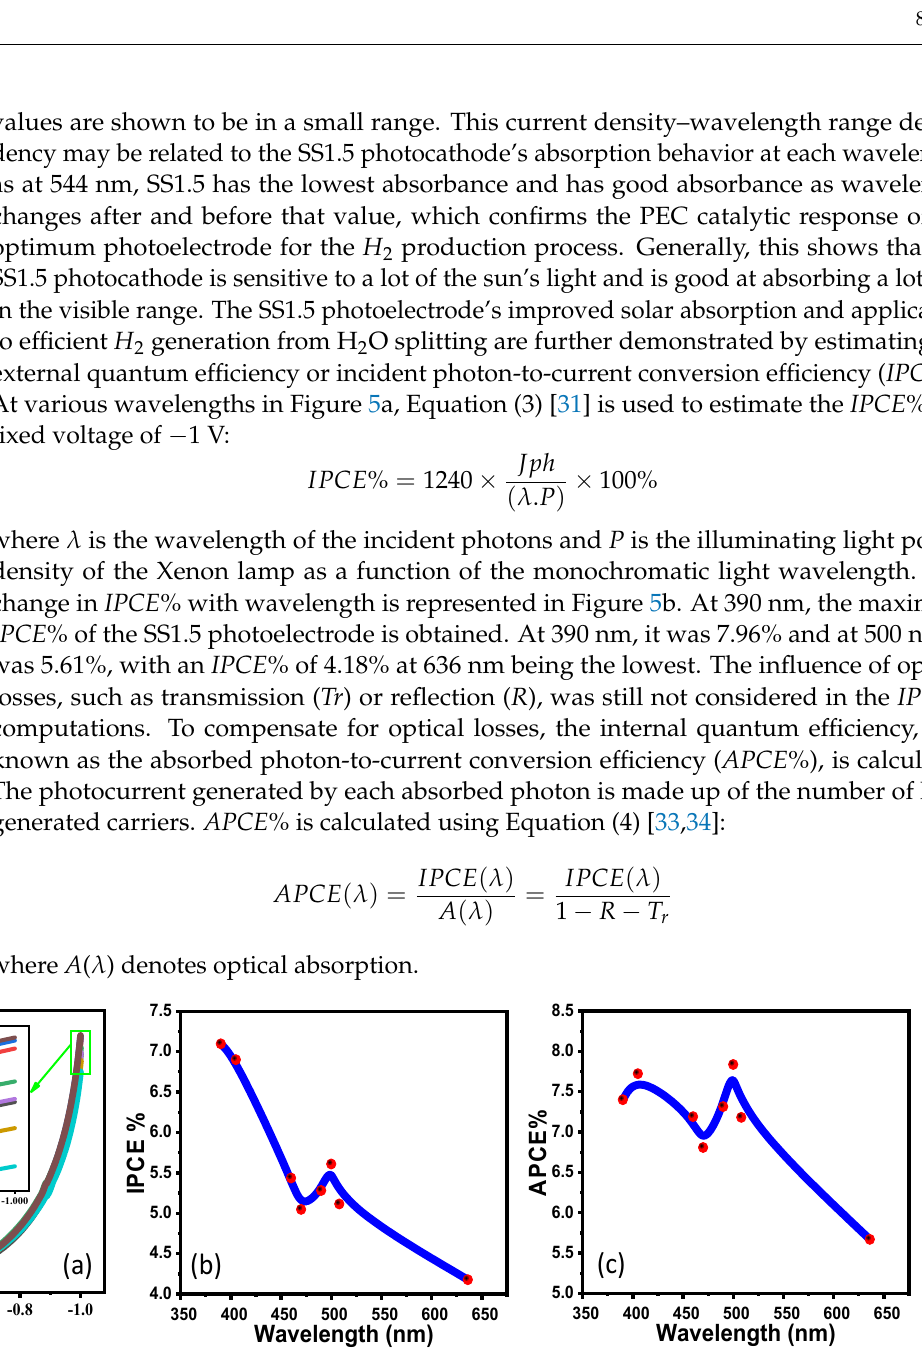
Figure 5. SS1.5 photocathode: ( a ) variation in current density vs. the applied voltage under mono- chromatic luminance, ( b ) IPCE % and ( c ) ABCE% versus the incident wavelength at −1 V.